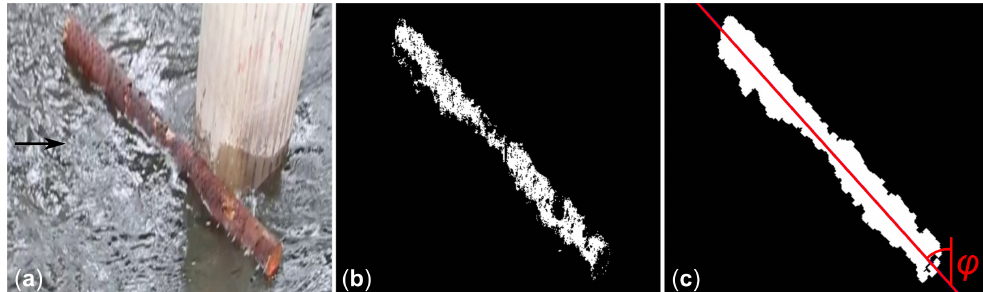
Figure 5. Automatic detection of log orientation with ( a ) cropped section of a perspectively transformed snapshot, ( b ) log detection using histogram backprojection, and ( c ) image dilation and fitting of a straight line to determine the yaw ϕ . Note that the color of the log should be easily distinguishable from the color of the water that surrounds the log. Therefore, the automatic detection was conducted for selected logs only.